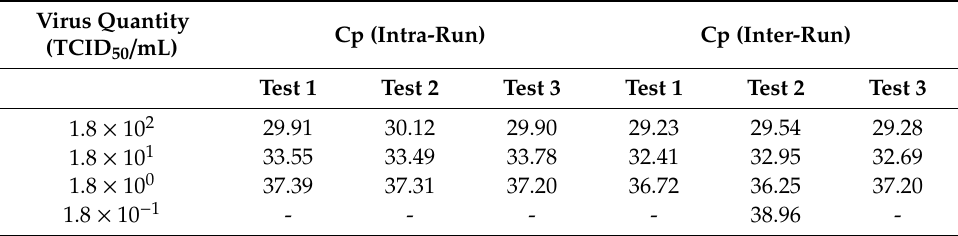
Cp: crossing point at which the fluorescence of a sample rises above the background fluorescence.